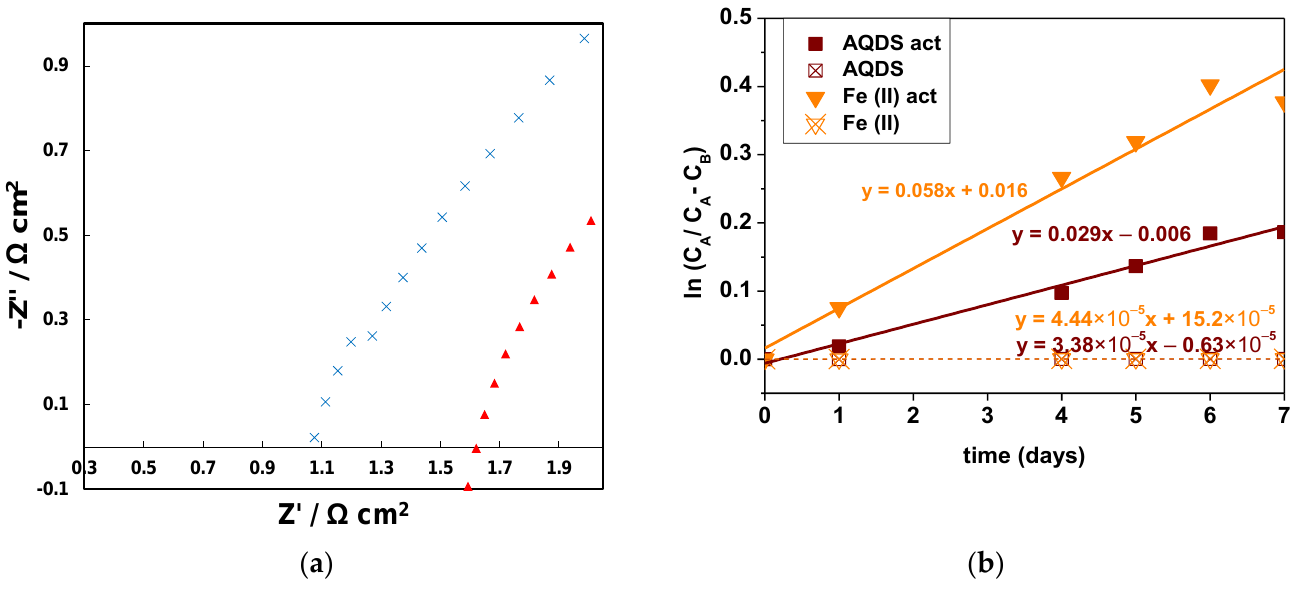
Figure 6. ( a ) Electrochemical impedance spectroscopy for both batteries in the high-frequency region of the Nyquist plot and schematic representation of the different resistances of the whole system. ( b ) Permeability evaluated from measurement in a H-cell using 100 mM of RAM in 1 M NaCl vs. 1 M NaCl for one week.